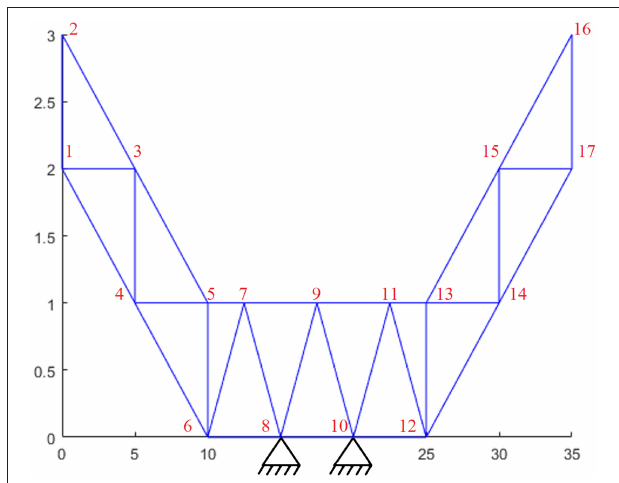
FIGURE 1 | The truss structure with dimensions in meters, numbering of nodes, and two supports at nodes 8 and 10.